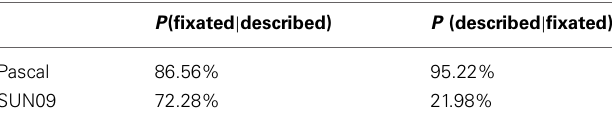
Table 2 | The fundamental relationships between object fixations and objects